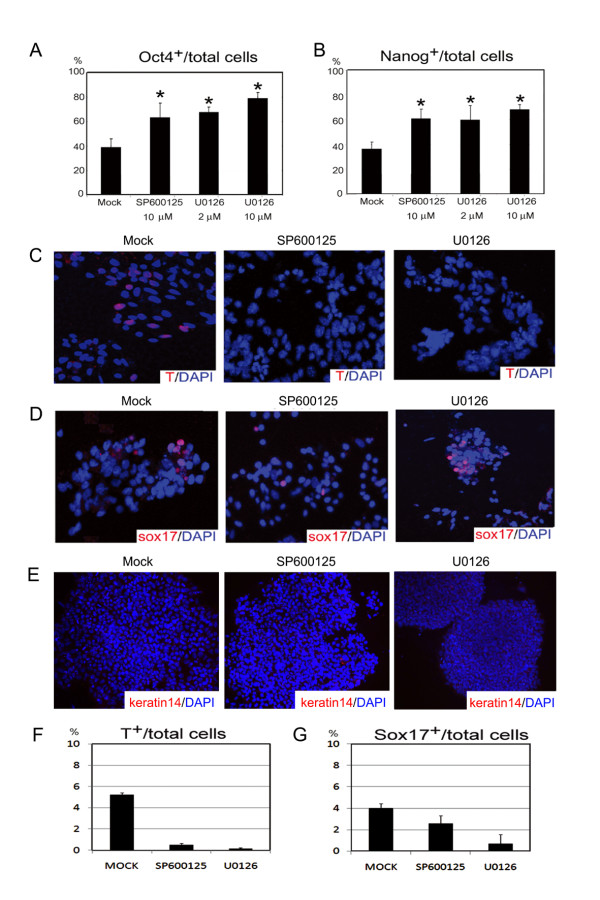
Both inhibitors of JNK and ERK retarded ES differentiation. After treatment with 10 μM SP600125, 2 or 10 μM U0126 from days 1-3, ES cells were plated on 0.1% matrigel-coated glasses and stained with anti-Oct4 (A) and anti-Nanog antibodies (B) on day 6. The ratio of undifferentiated pluripotent ES cells to total DAPI+ cells (n>500 cells) was estimated from experiments done in triplicate. Brachyury (T) (C), Sox17 (D) and cytokeratin 14 (E) expressions, representing mesodermal, endodermal and surface ectodermal cell lineages respectively, were examined in ES cells on day 6 with SFEB treatment. Nuclei of all cells are seen by DAPI staining in blue. The statistic results of the cell numbers in panel C and D were also estimated, respectively (E, F).